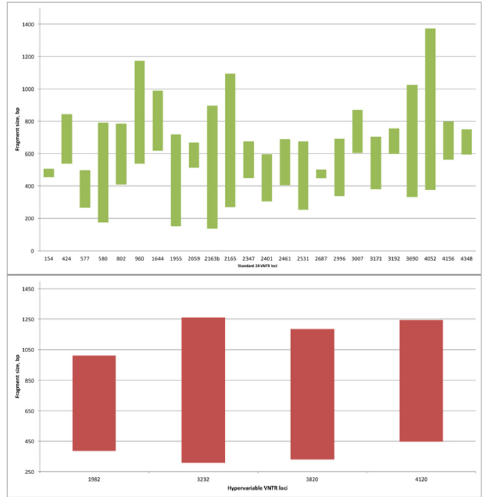
Fig 1. Sizes of PCR fragments determined by the QiaXcel system. A – Standard loci. B – Hypervariable